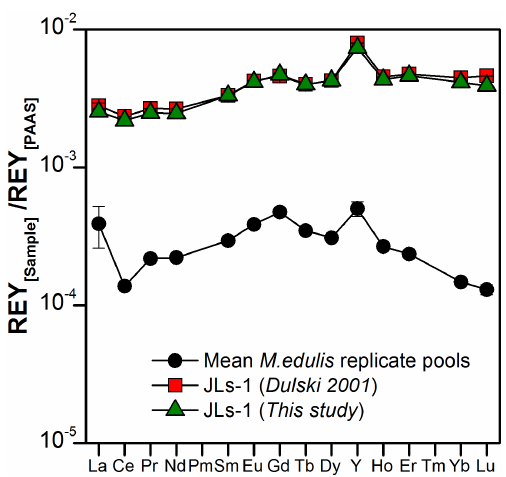
Figure 3. REY SN patterns of the four replicate pools of Mytilus edulis shells determined in our study and of international refer- ence standard JLs-1 (a Permian limestone from Japan; data from our study and from Dulski, 2001) used for analytical quality assess- ment during method development. Note that except for La and Y, error bars (1 σ) are smaller than the symbol